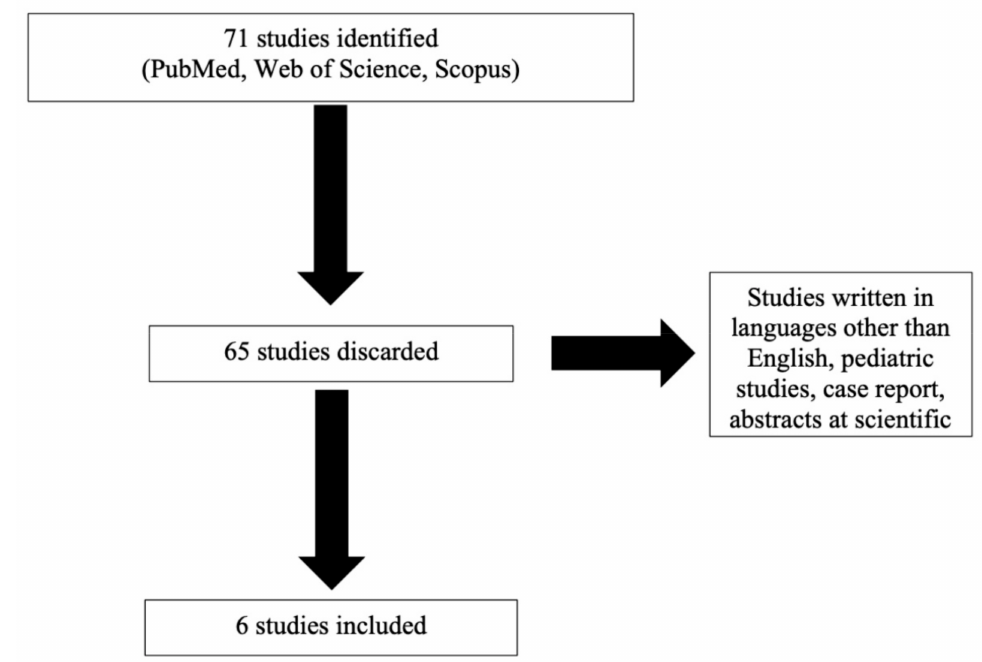
Figure 1. Research